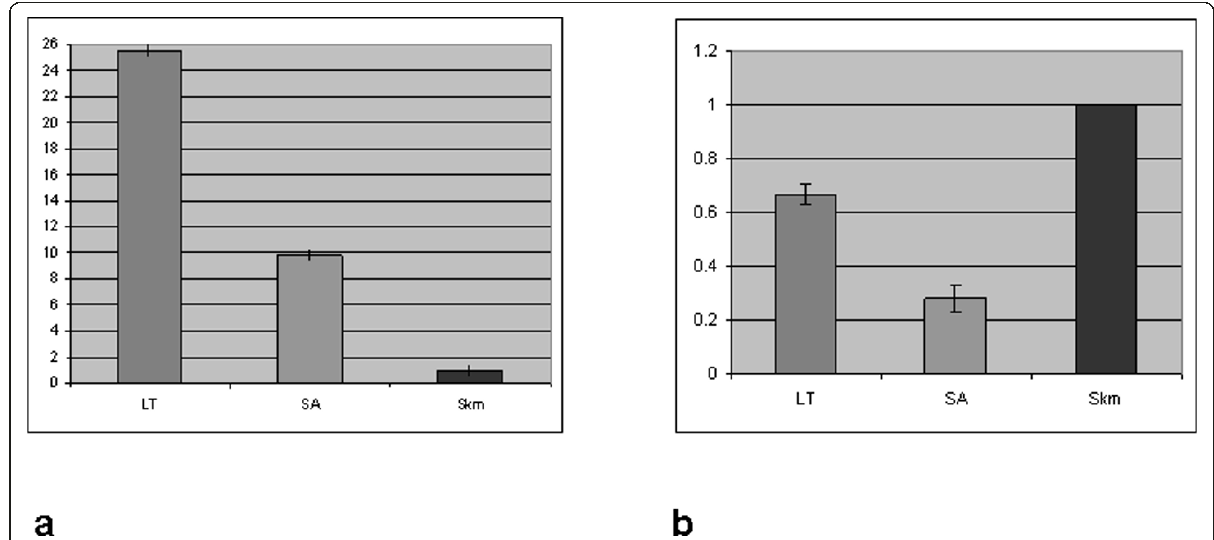
Figure 2 a. Levels of dystrophin B transcript expression (2- ΔΔ CT values) in the skeletal muscle of two 5 ’ XLDC patients (LT and SA), as compared to a control muscle (calibrator), using actin as reference gene . B upregulation resulted in 25- and 9-fold transcript levels in LT and SA, respectively. b Levels of dystrophin B transcript (2- ΔΔ CT values) in the skeletal muscle of the same 5 ’ XLDC patients, as compared to the level of dystrophin M transcript in a skeletal muscle control using actin as reference gene. The ratio was 0.67 and 0.28 in patients LT and SA,